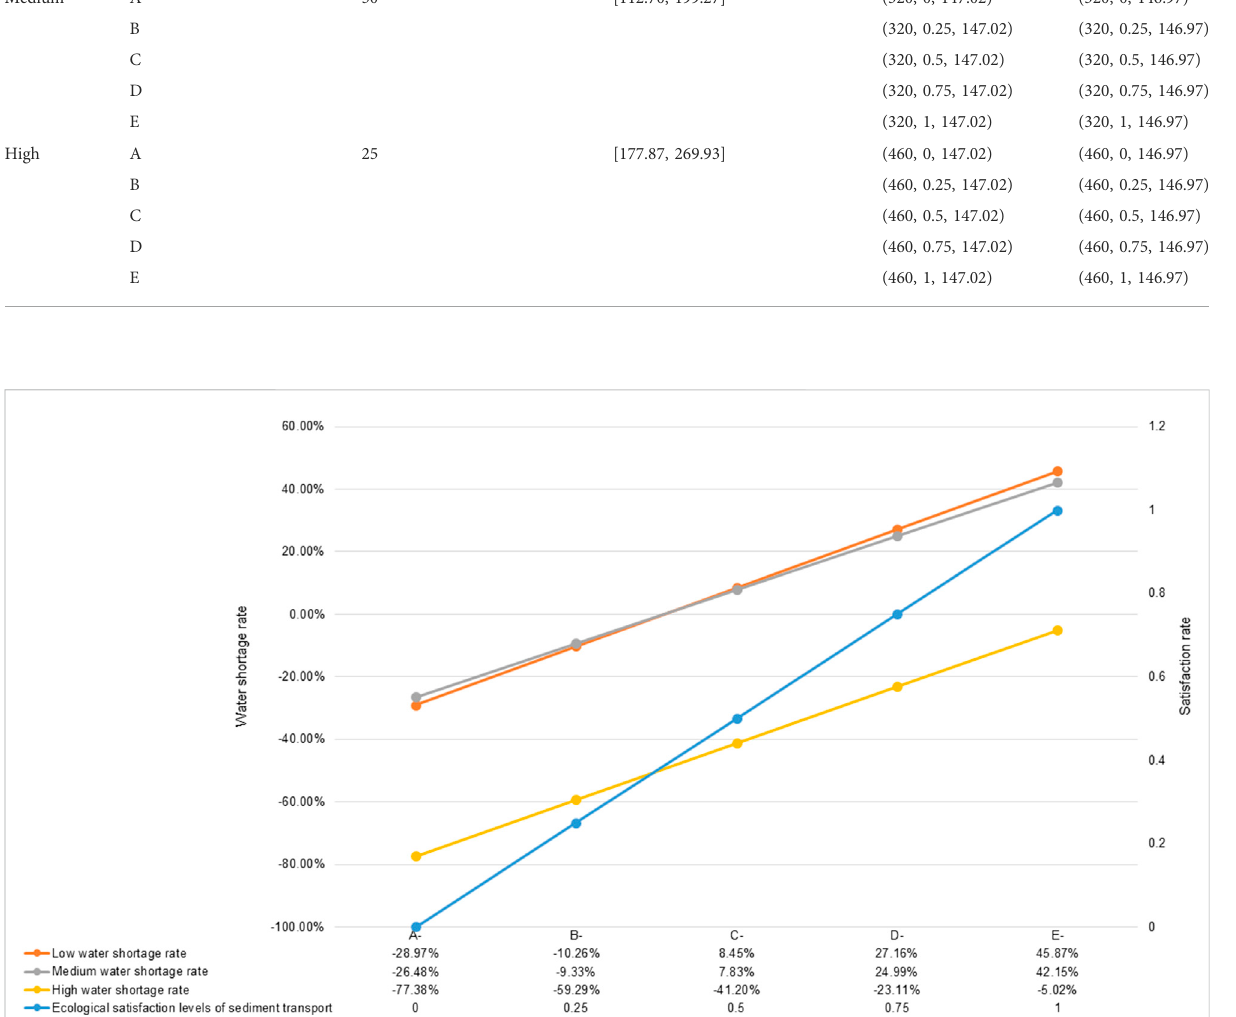
Frontiers in Earth